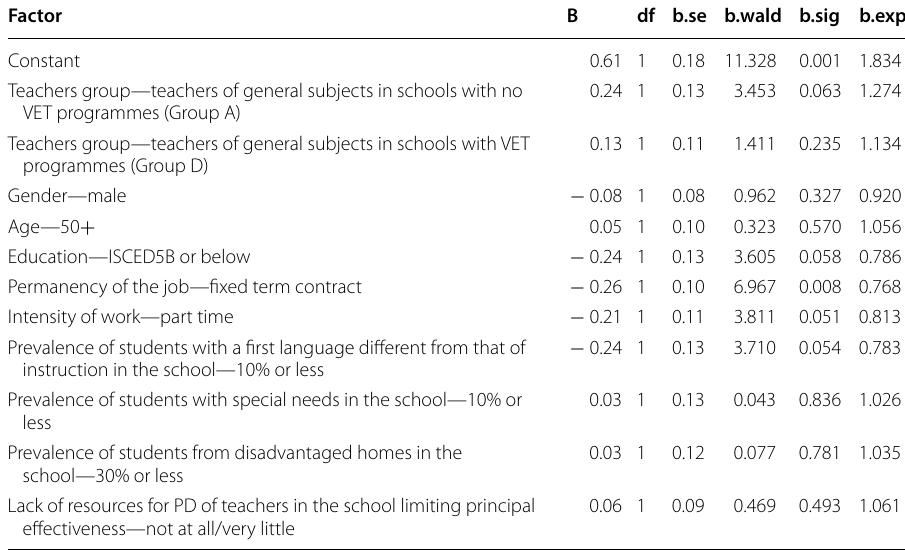
Table 20 Declaring conflict with work-schedule as a barrier to professional development, results of the logistic regression model, regressors R1–R10, Italy, 2013 (Source: Author’s calculations based on OECD, TALIS